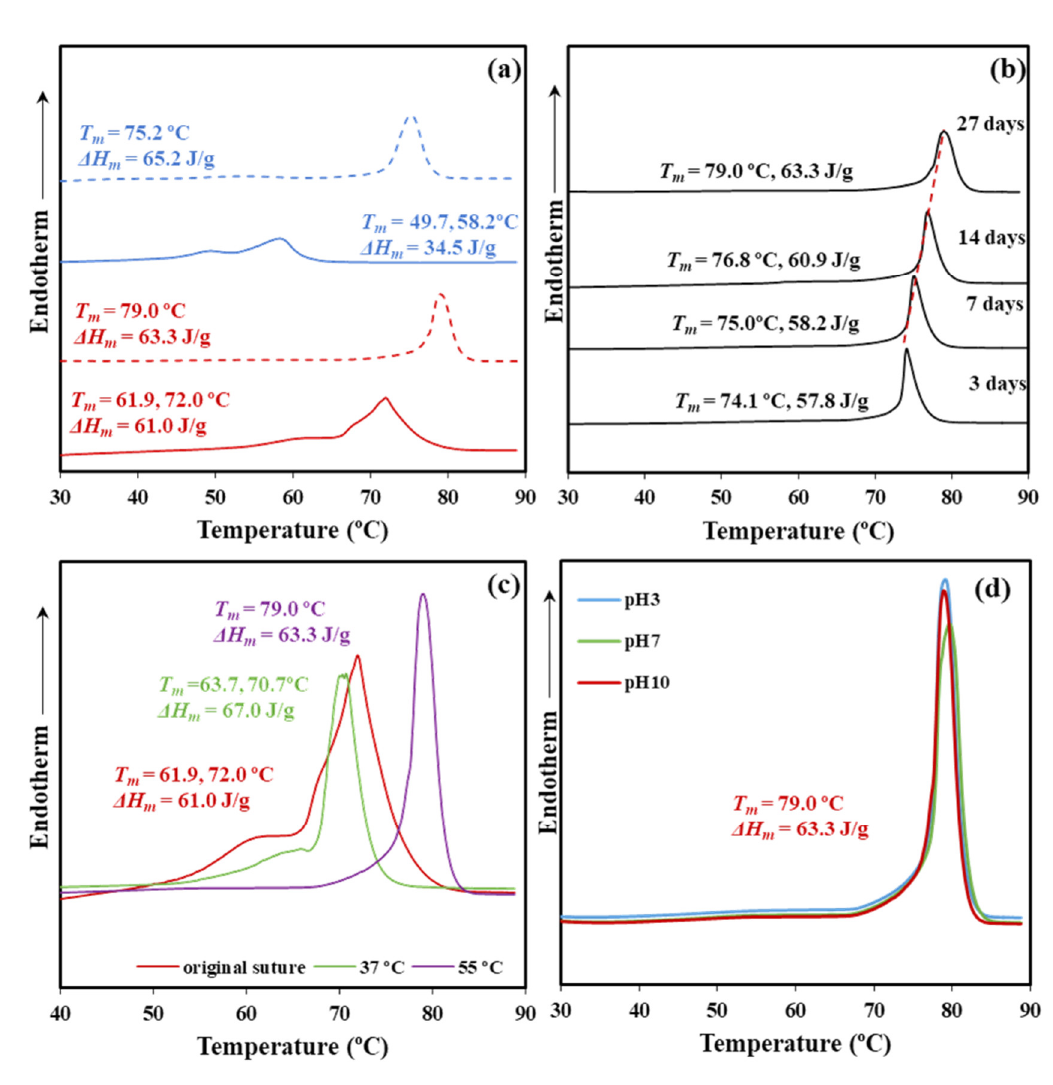
Figure 3. ( a ) DSC heating scans (10 °C/min) corresponding to a melt pressed film (blue) and the commercial suture (red) before exposure (solid line) and after exposure (dashed line) for 27 days to a pH 10 hydrolytic medium at 55 °C. ( b ) DSC heating runs of commercial sutures exposed for the indicated days to a pH 10 medium at 55 °C. ( c ) DSC heating runs of commercial sutures exposed at a pH 10 medium for 27 days and temperatures of 37 and 55 °C. For the sake of completeness, the curve for the commercial suture is also drawn. ( d ) DSC heating runs of commercial sutures exposed at pH 3, pH 7, and pH 10 media for 27 days and 55 °C.